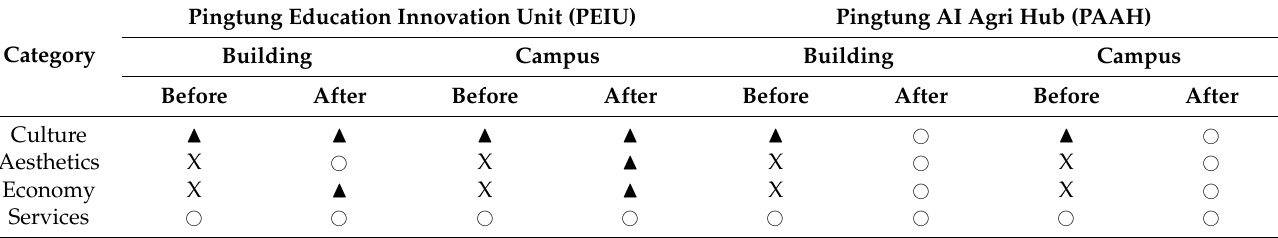
Table 5. Environmental value Analysis of Campus